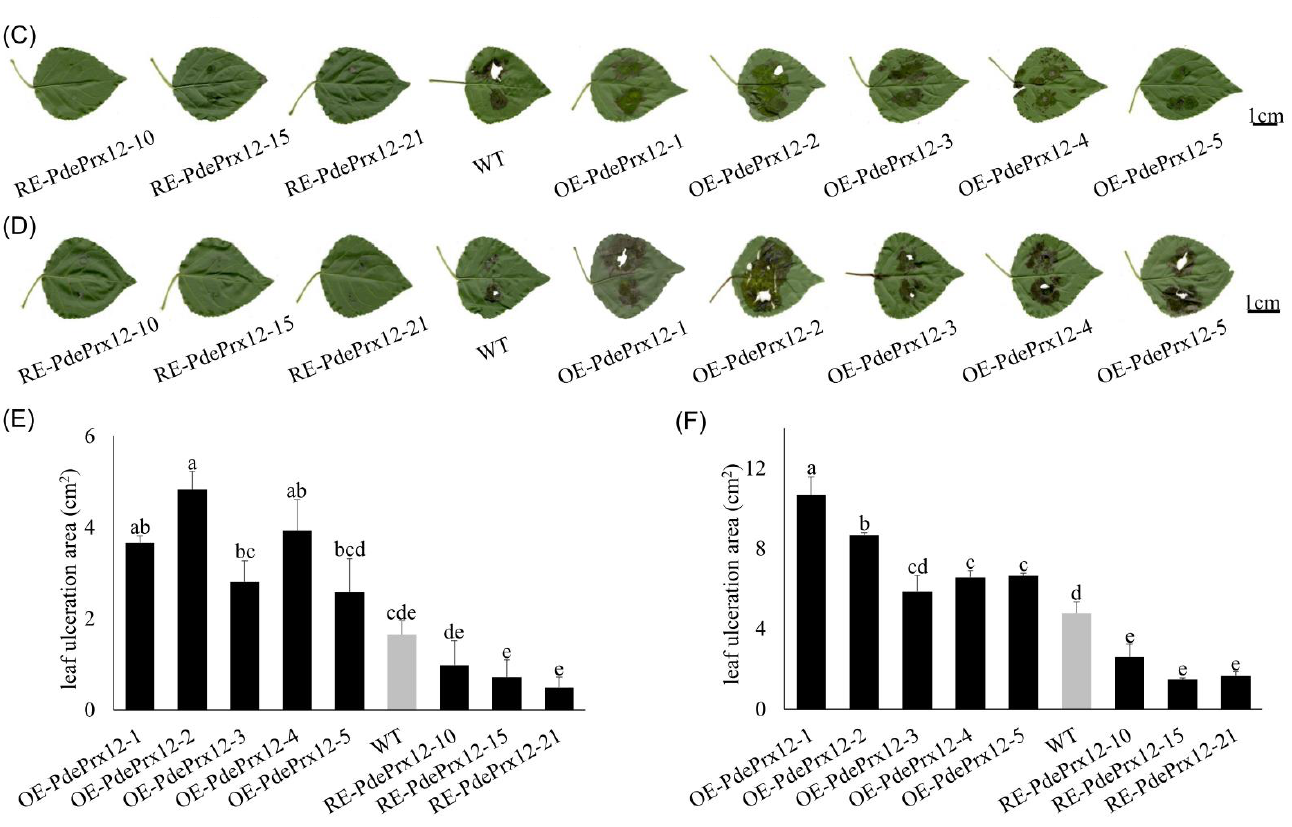
Figure 4. Phenotypes of the PdePrx12 transgenic lines. ( A ) Determination of H 2 O 2 content in OE/RE- PdePrx12 and WT lines (mmol/g FW). Determination of H 2 O 2 content in OE/RE-PdePrx12 and WT lines. The content of H 2 O 2 in WT was set to 1. The letters in the figure indicate differences based on multiple comparisons ( p = 0.05). ( B ) DAB staining of OE/RE-PdePrx12 and WT leaves (bar = 1 cm). ( C ) Phenotypic observation of OE/RE-PdePrx12 and WT under the infection of pathogen 3C on the 7th day (bar = 1 cm). ( D ). Phenotypic observation of OE/RE-PdePrx12 and WT under the infection of pathogen 3E on the 14th day (bar = 1 cm). ( E ) The mean values of the infected area of leaves of OE, RE and WT lines by pathogen 3C were statistically analyzed by Image-Pro Plus image processing software. The letters in the graphs indicate differences based on multiple comparisons ( p = 0.05). ( F ) The mean values of the infected area of leaves of OE, RE, and WT lines by pathogen 3E were statistically analyzed by Image-Pro Plus image processing software. The letters in the graphs indicate differences based on multiple comparisons ( p = 0.05).